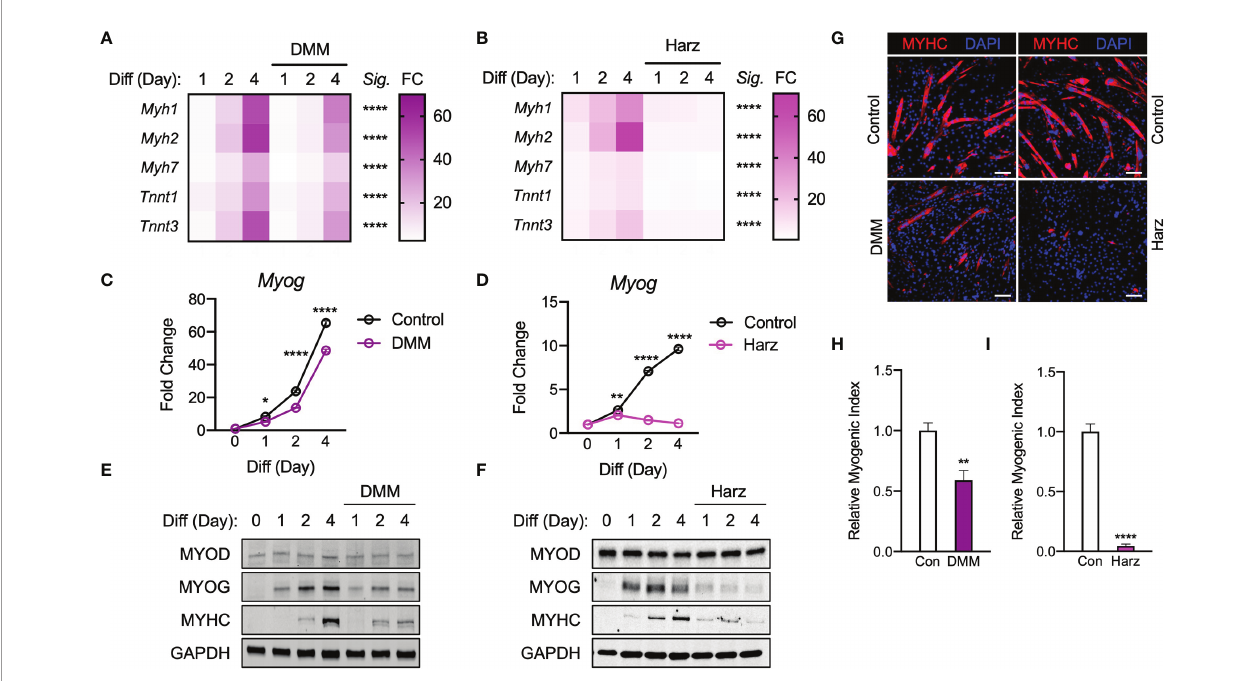
FIGURE 4 | Malonate and pharmacological inhibitor of succinate dehydrogenase repress C2C12 myogenesis via similar mechanism of action to that of itaconate and its derivatives. Heatmap depiction of average fold change ( Sig. denotes statistical differences at day 4, n = 3) in myogenic gene transcription levels detected via RT-qPCR when exposed to differential media with or without (A) dimethyl malonate (DMM: 5 mM) and (B) harzianopyridone (Harz: 4 µM) relative to the untreated group over a 4-day time course. Fold change of Myog mRNA expression at various time points comparing differentiation media (DM) control groups to (C) DMI and (D) 4-OI groups relative to expression without either treatment (n = 3). Western blotting data showing differences in myogenic transcription factor expression between DM treated groups and groups treated with DM plus (E) DMM and (F) Harz over a 4 day time course as well as groups which were not exposed to either treatment for any period. (G) MYHC staining at day 4 of differentiation. Bar: 100 m m. Relative myogenic index (percentage of total nuclei associated with myotubes) of (H) DMM and (I) Harz. * denotes p< 0.05, ** p <0.01, **** p <0.0001 compared to control based on